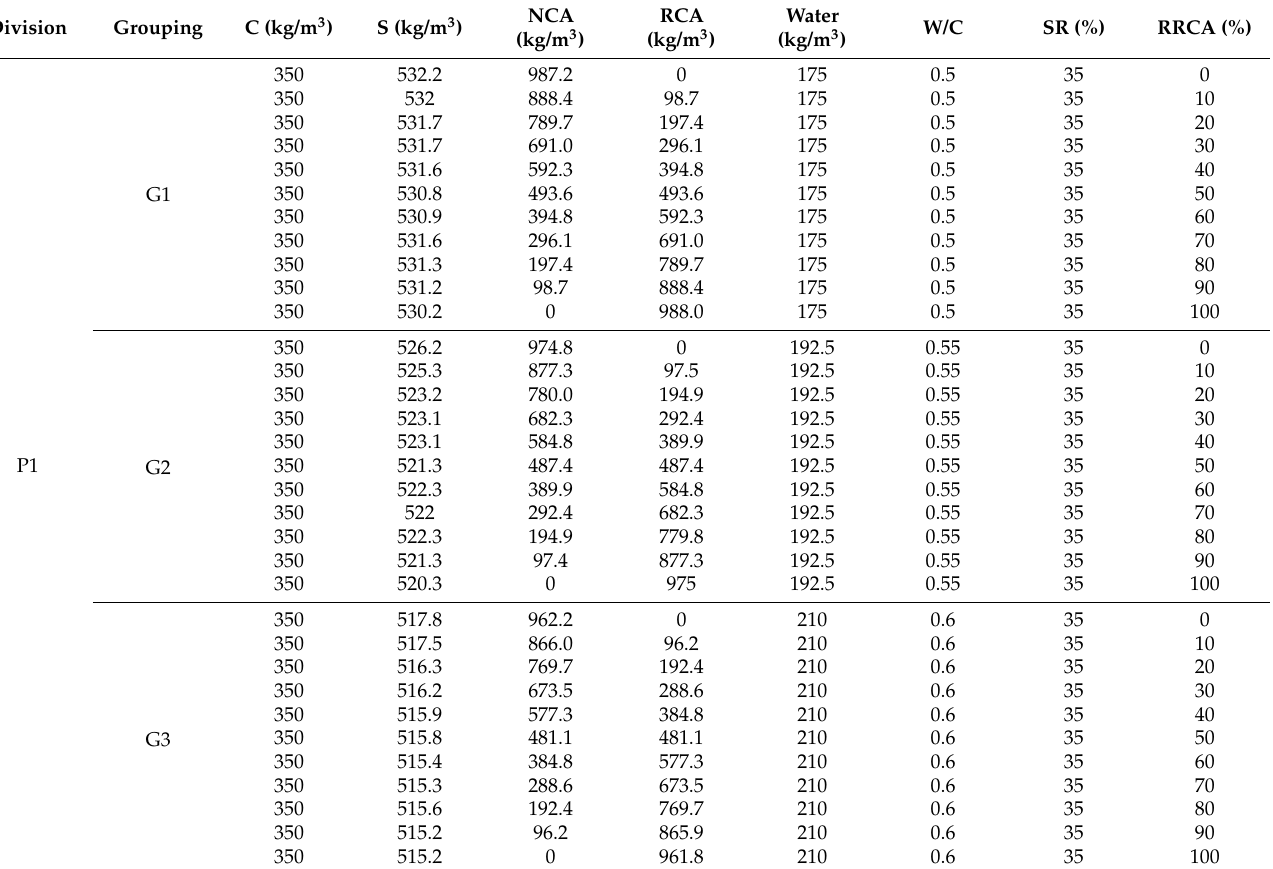
Table 4. Experimental mixing proportion data.